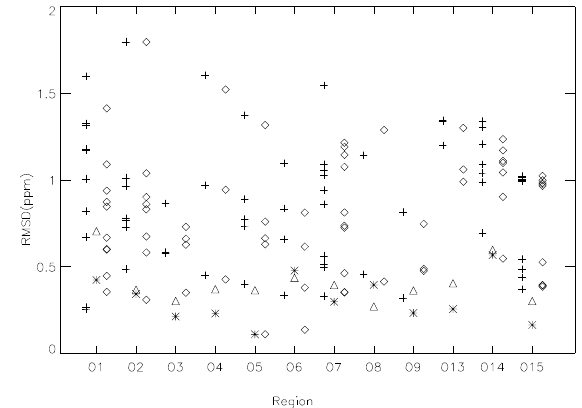
Fig. 10. Comparisons of RMSD at each station and regionally aver- Fig. 10 Comparisons of RMSD at each station and regionally averaged values between aged values between model results and observations for the ocean model results and observations for the ocean regions in 2006. Each region is shown in Fig. 4. regions in 2006. Each region is shown in Fig. 4. Triangle (aster- Triangle (Asterisk) denotes RMSD of regionally averaged values between model results using isk) denotes RMSD of regionally averaged values between model fluxes from CASA (VEGAS) and observations, cross (diamond) denotes RMSD of each station results using fluxes from CASA (VEGAS) and observations; cross (diamond) denotes RMSD of each station between model results us- between model results using fluxes from CASA (VEGAS) and observations(See the legend in ing fluxes from CASA (VEGAS) and observations (see the legend Fig.8). in Fig.